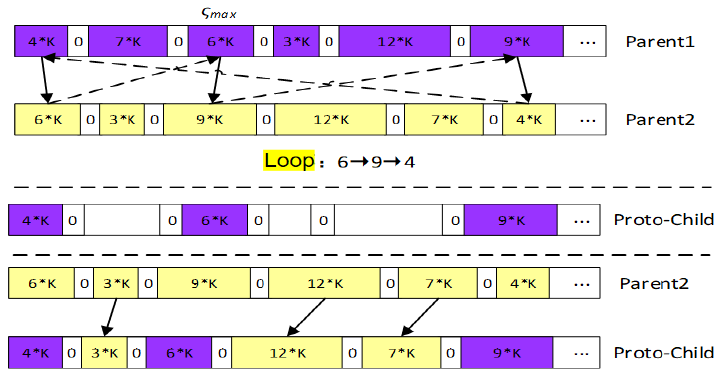
Figure 6. Crossover of tasks. The tasks’ crossover after performing the selection operation. Through these steps, we can gradually get the best result.